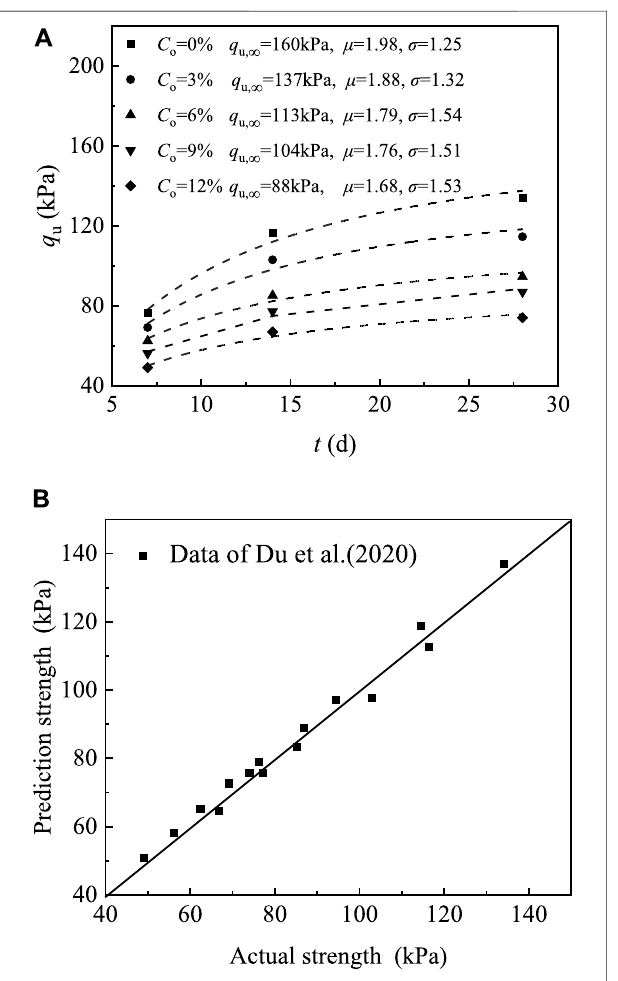
FIGURE 6 | Model validation results. (A) Model fi tting prediction results. (B) Comparison of measured and calculated strength.